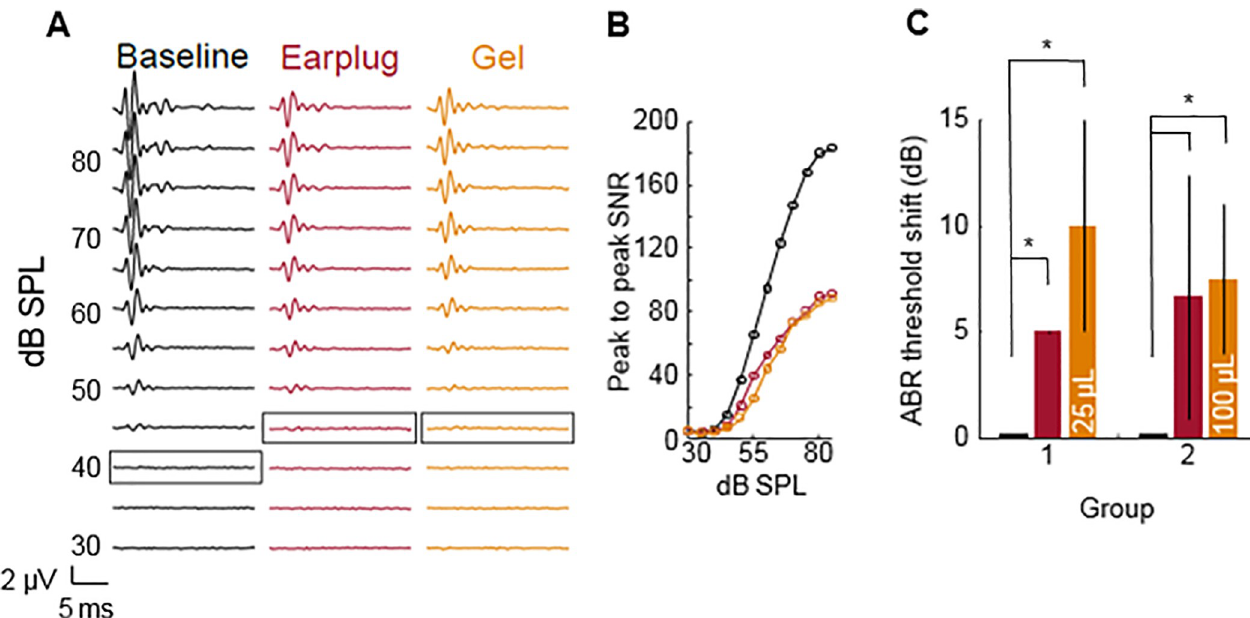
Fig 7. Threshold shifts recorded via auditory brainstem response (ABR) in guinea pigs. Each group was tested with both ears unplugged as baseline, left ear plugged with earplug, and right ear with gel applied. Group 1 received a 25 μ L gel drop and Group 2 received a 100 μ L gel drop. Representative ABR traces (A) and peak to peak signal to noise ratio (SNR) (B) are shown along with threshold shift relative to baseline for each group (C). Threshold shift in sound pressure level (SPL) are indicated with a box (A). Threshold shifts are represented as mean ± standard error for n = 3 animals per group (n = 2 for 100 μ L gel drop testing scenario). Threshold shifts within each group were analyzed for statistical significance ( � p < 0.05) with Kruskal-Wallis test and Dunn’s post-hoc testing. Significant differences in threshold shift due to applied gel volumes were analyzed with Mann Whitney U